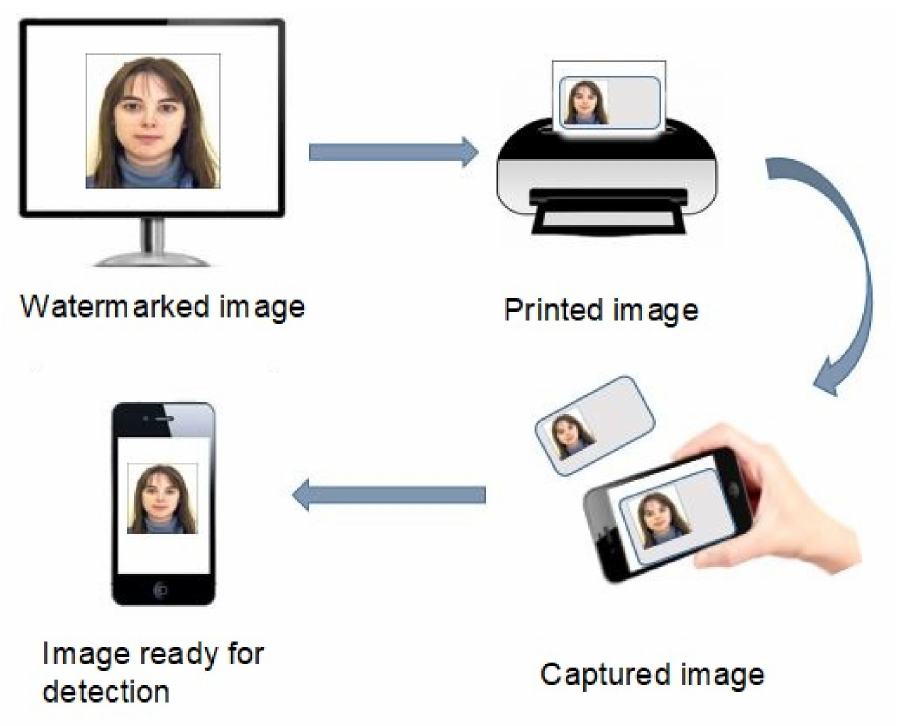
Figure 1. Print-cam process